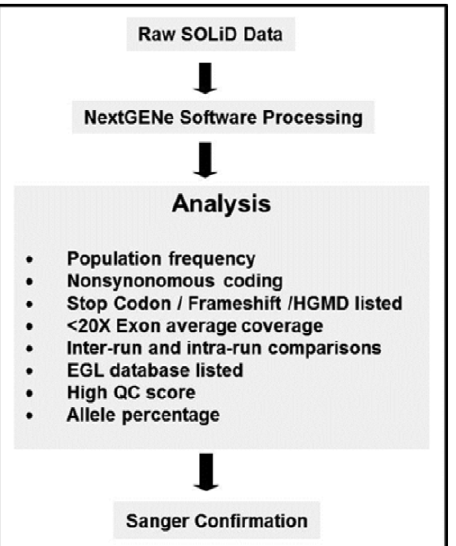
Figure 2. Schematic diagram of the analysis workflow. The flowchart demonstrates the criteria used to select variants that were Sanger sequencing confirmed. In essence, selected variants that had . 20 6 coverage, a low allele frequency, and nonsynonymous changes were Sanger confirmed if they were listed on HGMD, frameshift, or nonsense changes. In addition, interesting variants with a coverage , 20 6 were also confirmed (Table 7). doi:10.1371/journal.pone.0053083.g002 PLOS ONE |